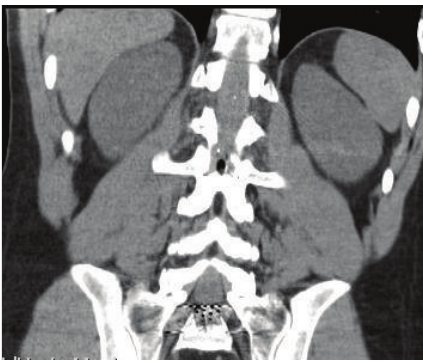
Figure 4: In the coronal CT scan we can see the damage to the posterior arc of L2 that was the entry point of the bullet.